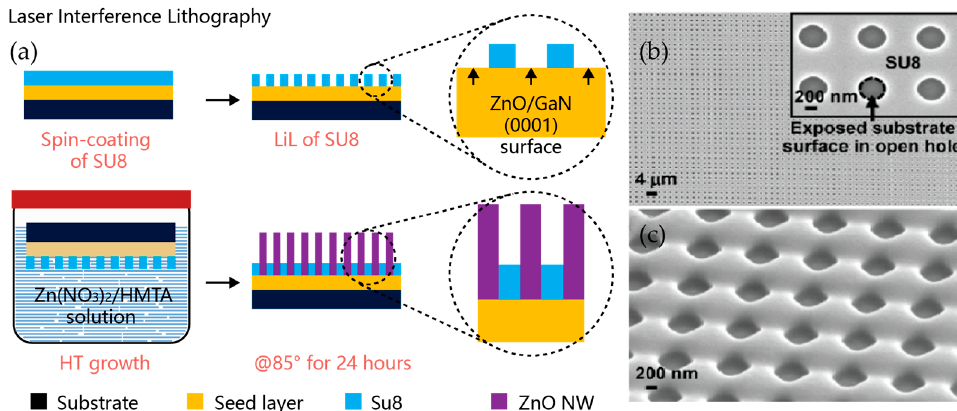
Figure 2. Schematics of the manufacturing process of ZnO NW arrays using laser interference techniques: ( a ) Fabrication process using the LIL approach for large ‐ scale patterned ZnO NW arrays; ( b ) scanning electron microscope (SEM) image of patterned SU ‐ 8 film; ( c ) SEM image of patterned photoresist film [53].